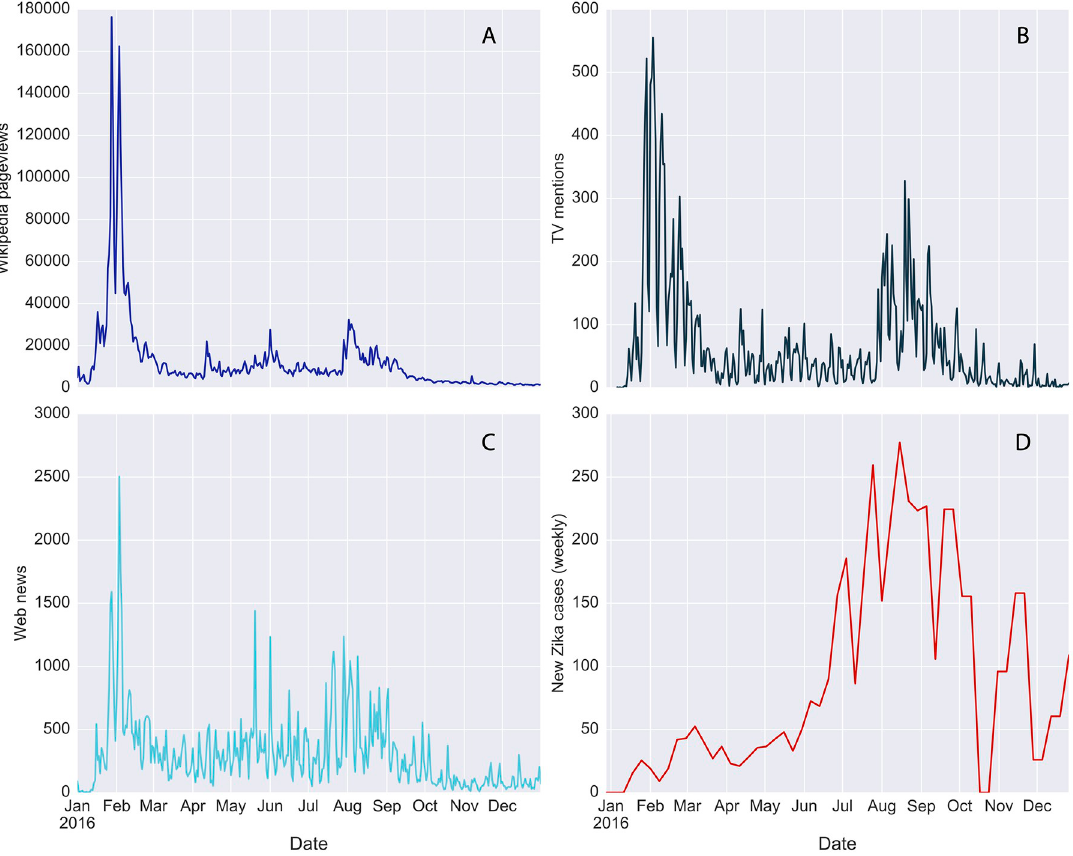
Fig 1. Attention, media coverage and disease incidence of the Zika virus in the USA in 2016. ( A ) Daily Wikipedia pageview counts of Zika related pages. B , Daily mentions of the word “Zika” in TV programs broadcasted in the U.S. extracted from the TV Internet Archive. C , Daily number of Web news mentioning “Zika” extracted from the GDELT project. D , Weekly incidence of the Zika virus reported by the CDC. Originally reported case counts were smoothed with a biweekly rolling